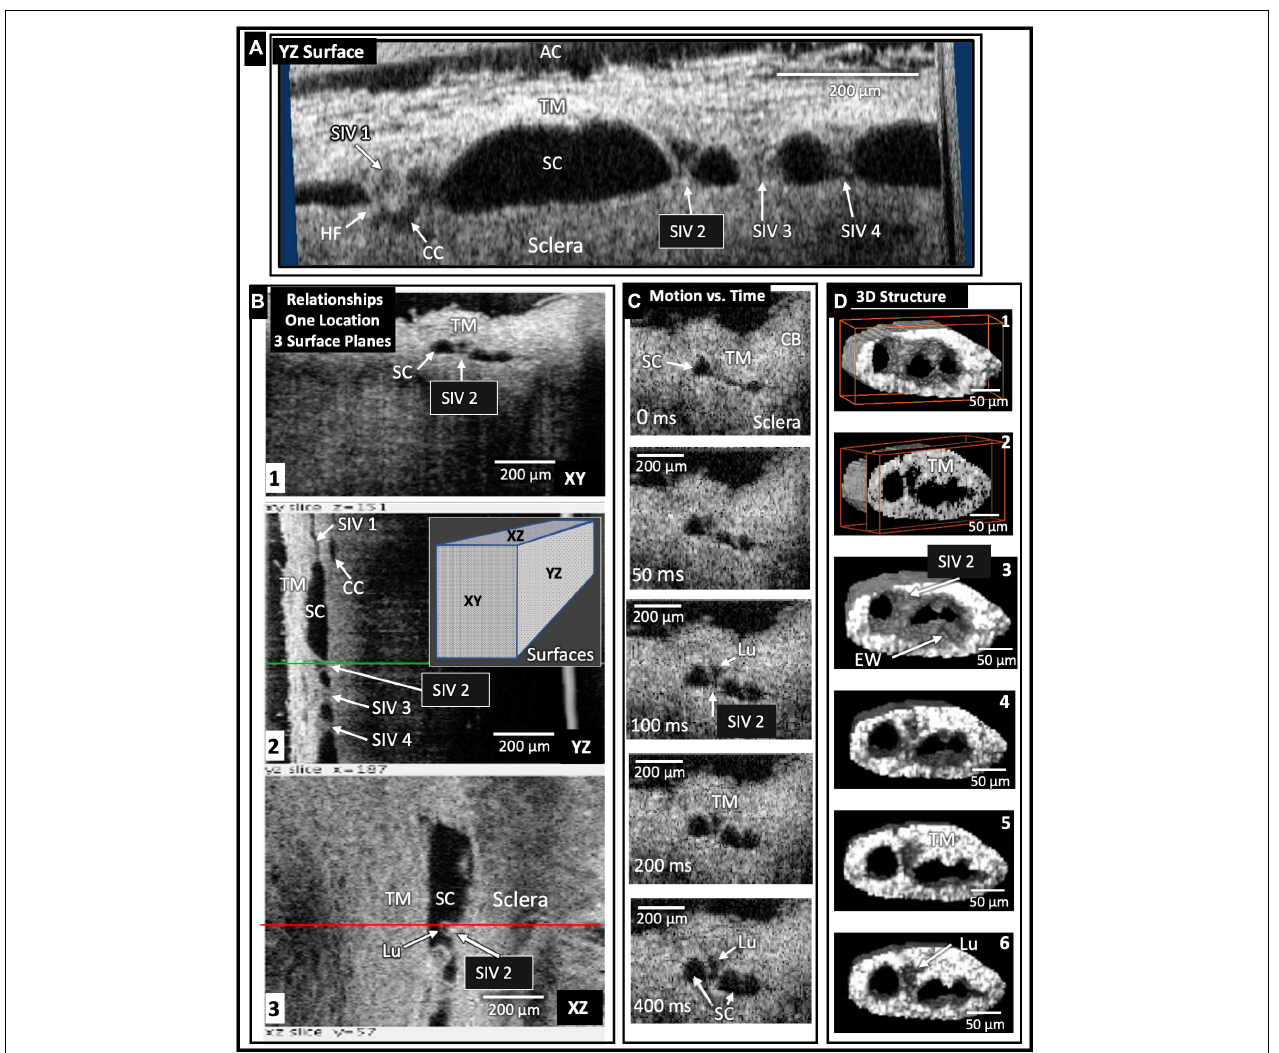
FIGURE 5 | Schlemm’s canal inlet valve-like structure (SIV) 3D relationships and motion. Images from high-resolution OCT captured 3D volumes (XYZ) while maintaining 30 mm Hg SC hydrostatic pressure. Trabecular meshwork (TM), Schlemm’s canal (SC), the scleral or external wall (EW) of SC, and CC relationships, as well as SIV connections, are apparent in the XY, YZ, and XZ relationships of (A,B) . Four SIV crossing SC are visible in (A) . At SIV1, a hinged flap (HF) is visible at a CC entrance. In (B) , the SIV2 appearance in each plane at one location seen in XY, YZ (green line), and XZ (red line) provides an improved appreciation of relationships and lumen appearance compared with XY alone. In (C) , the motion was captured using high-resolution OCT 2D imaging while SC pressure changed from 0 to 30 mm Hg. Most of the SIV2 lumen volume change occurred in < 200 ms. In (D) , a mask eliminated surrounding structures providing 3D images of the surface appearance (D1) and internal structure at increased depths as indicated by the red box advance into the volume (D2) . (D3) through (D6) show surface volumes at increasing depth. The funnel-shaped deformation of the TM and SIV lumen (Lu) exiting from the TM is consistent with the strain induced by pressure-dependent stresses on the connections between the TM, SIV, and SC external